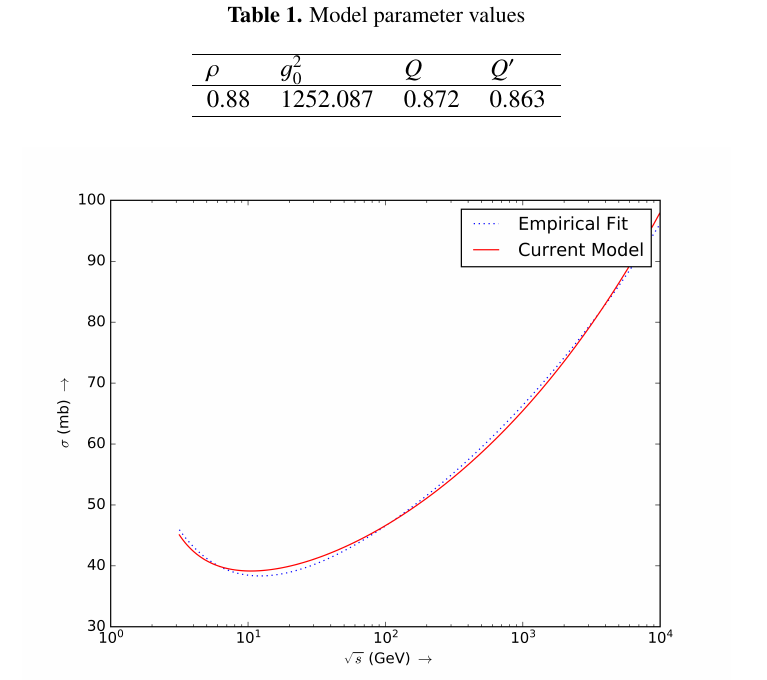
Table 1. Model parameter values